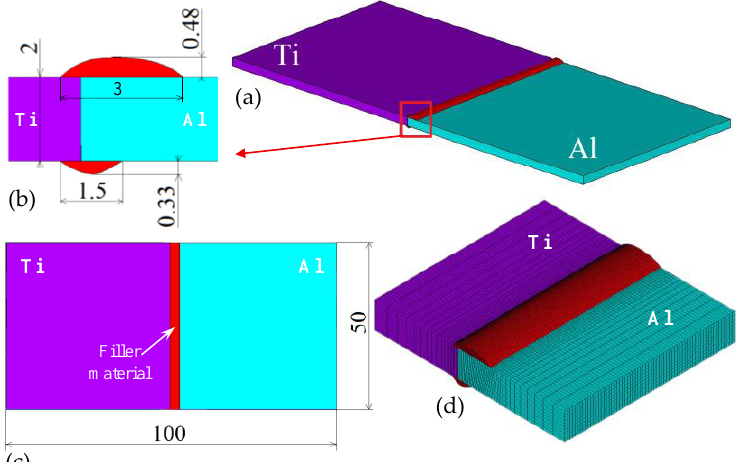
Figure 1. Geometric model ( a ) with the dimensions in front view ( b ) and top view ( c ) and a detail of the generated FE mesh ( d ).